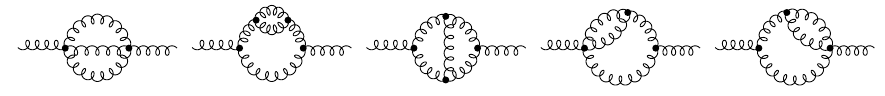
Figure 3 . Two-loop diagrams for the gluon two-point function. Here, we only include the two- particle irreducible (2PI) gluon self-energies in each diagram.